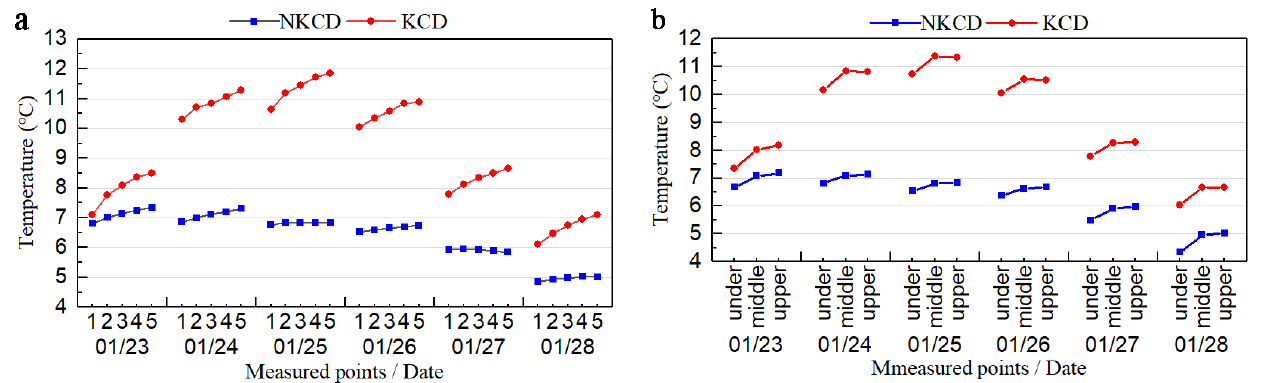
Figure 14. Statistics of indoor air temperature distribution along with the depth and height: ( a ) depth direction; ( b ) height direction.